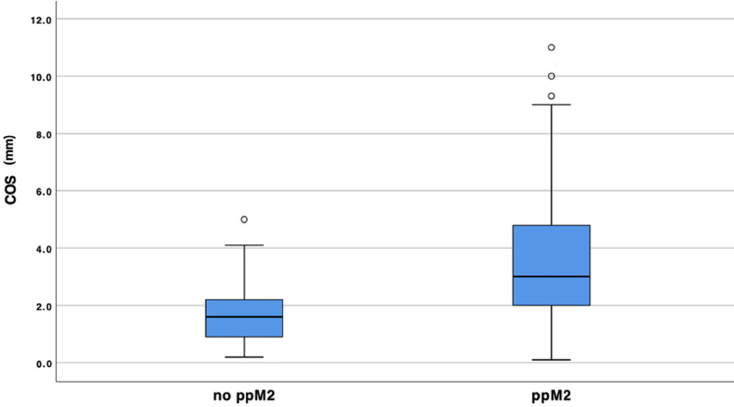
Figure 2. COS depth experimental versus control group. Table 2. COS depth experimental versus control group.